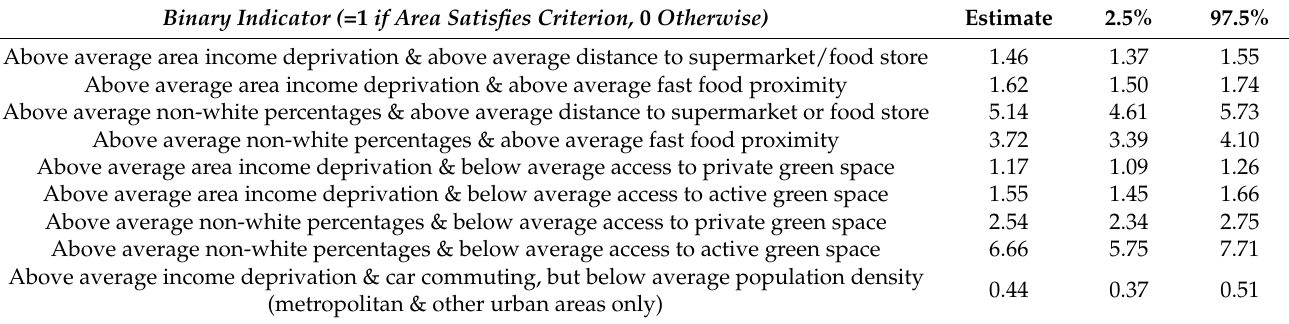
Table 2. Obesogenicity, Second Measurement Model, Loadings on Binary